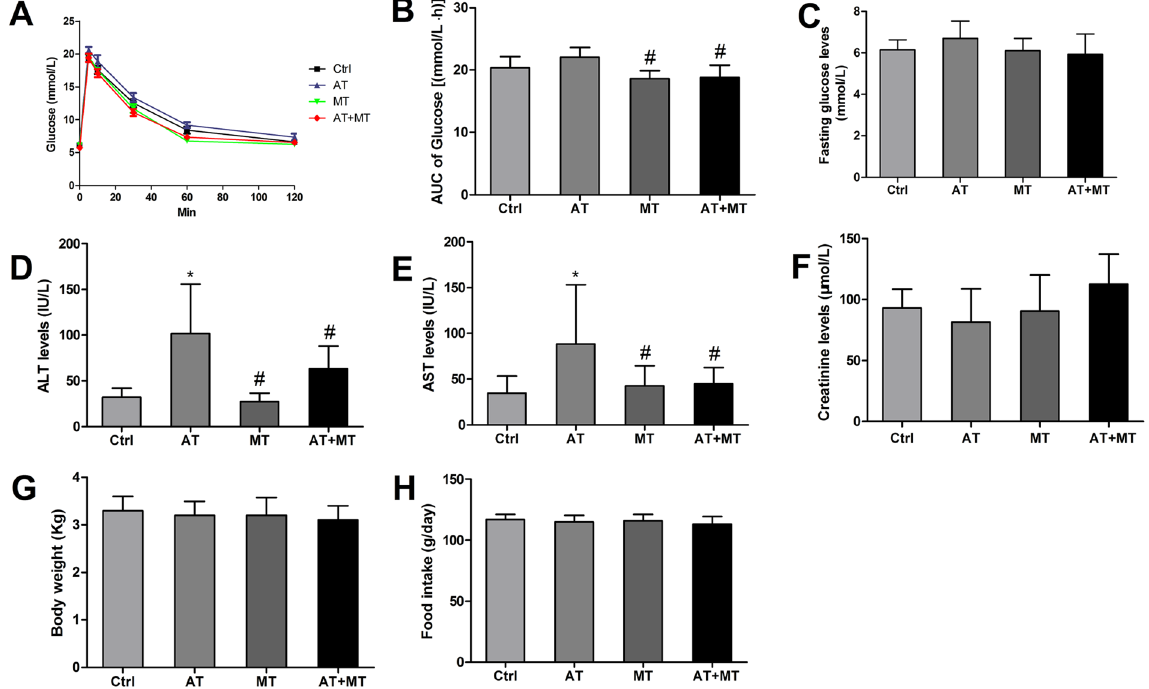
Figure 3. Metformin added to atorvastatin therapy is well tolerated and partially reversed atorvastatin- induced adverse effects. At 10 weeks after medication administration, the intravenous glucose tolerance test was performed. Briefly, rabbits were fasted overnight, then a bolus of glucose (0.6 g/kg body weight) was injected into the ear vein, and blood samples were collected at 0, 5, 10, 30, 60, and 120 min. Time-dependent changes in plasma glucose levels ( A ) and their AUC values ( B ) are presented. Fasting plasma glucose levels ( C ), serum concentrations of ALT ( D ), AST ( E ) and creatinine ( F ), body weight ( G ) and food intake ( H ) were also measured at 10 weeks after medication administration. Data are mean ± SD, n = 7 for each group. * P < 0.05, compared with Ctrl group; # P < 0.05, compared with AT group. Ctrl, control group; AT, atorvastatin group; MT, metformin group; AT + MT group, atorvastatin/metformin combination therapy group. ALT: alanine transaminase; AST: aspartate transaminase; AUC, area under the